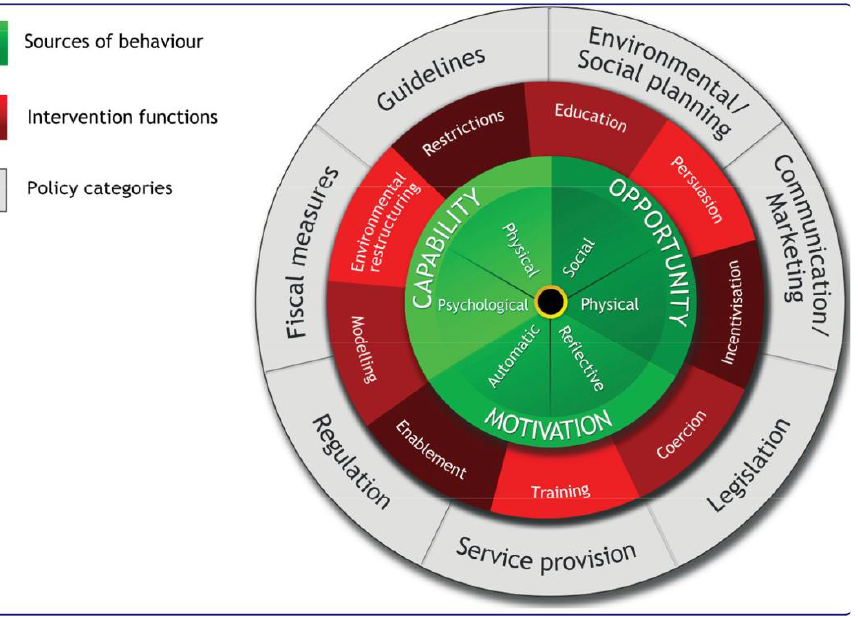
Figure 1. The Behavior Change Wheel (used with permission from Michie et al. [14]).